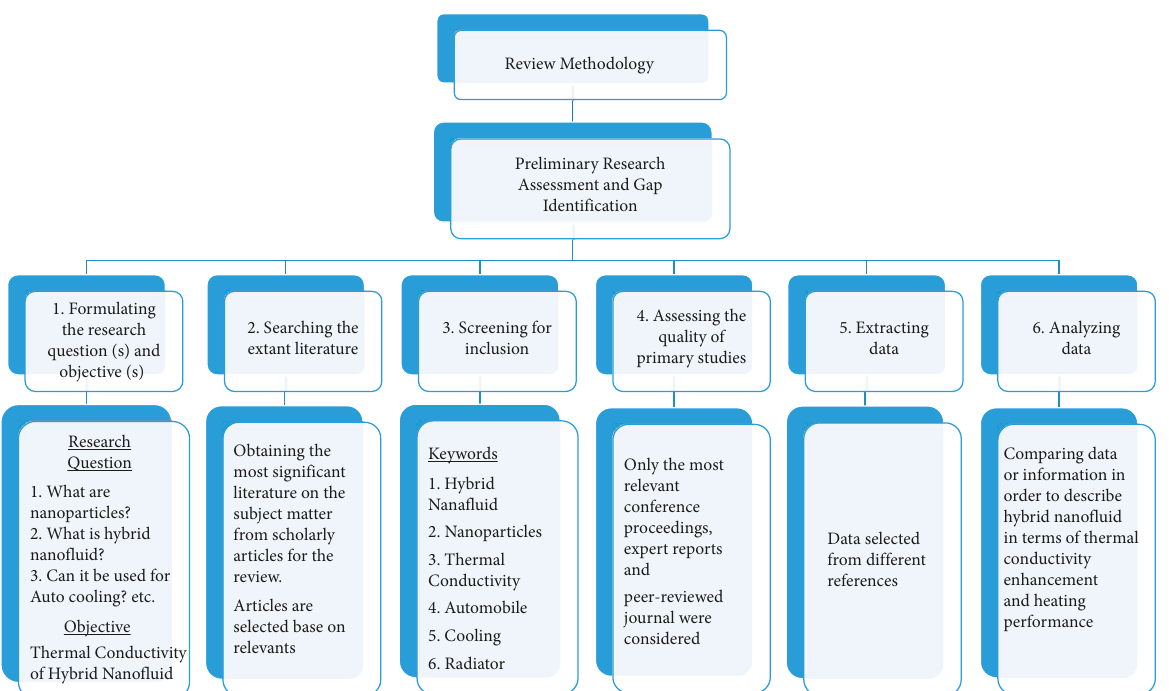
Figure 5: Schematic layout of the research review method.